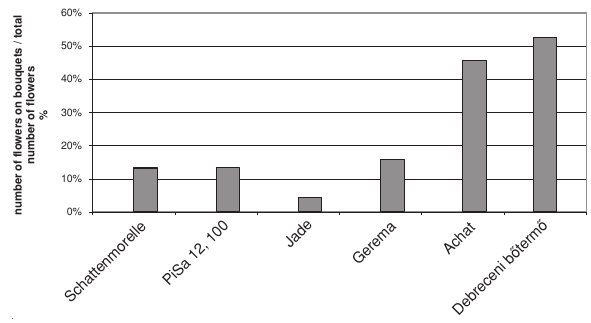
Figure 7. The ratio of flowers grown in bouquets shows marked differences between varieties ( Debrecen-Pallag,